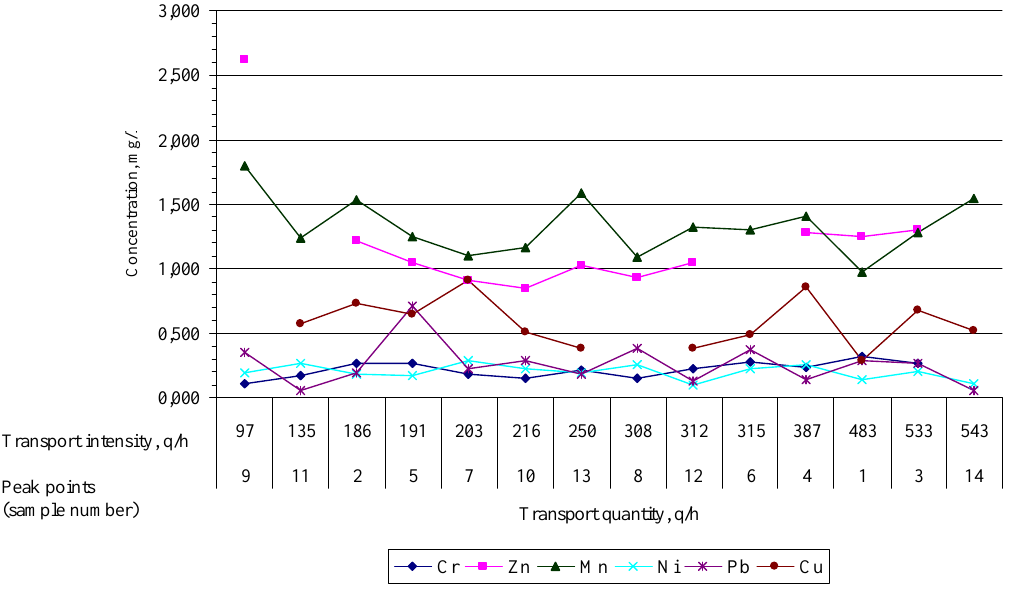
Fig. 2*. Comparison of heavy metals concentration (mg/l) of sweeps by transport quantity (q/h) at peak points *Comment. There are gaps in point 6 and 11 of Zn and in point 8 of Cu, because results are above confidence interval